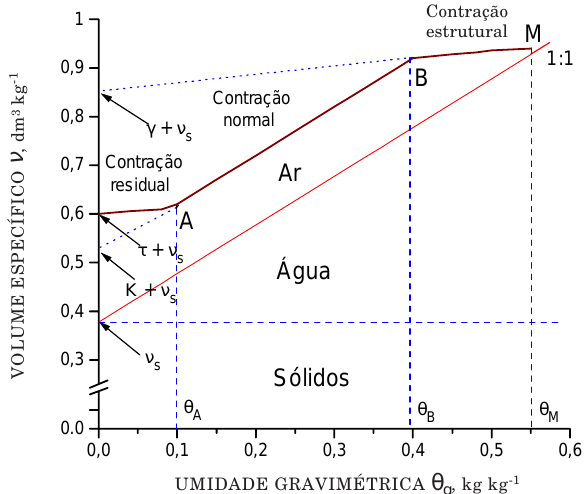
Figura 1. Representação do modelo das três retas, mostrando o comportamento variável do volume do solo sob diferentes condições de umidade (McGarry & Malafant,